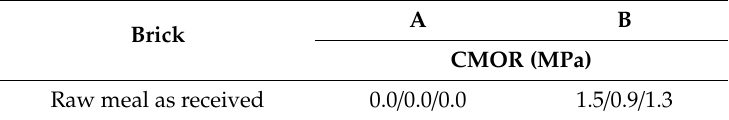
Table 5. Evaluation of sandwich coating test for the bricks A and